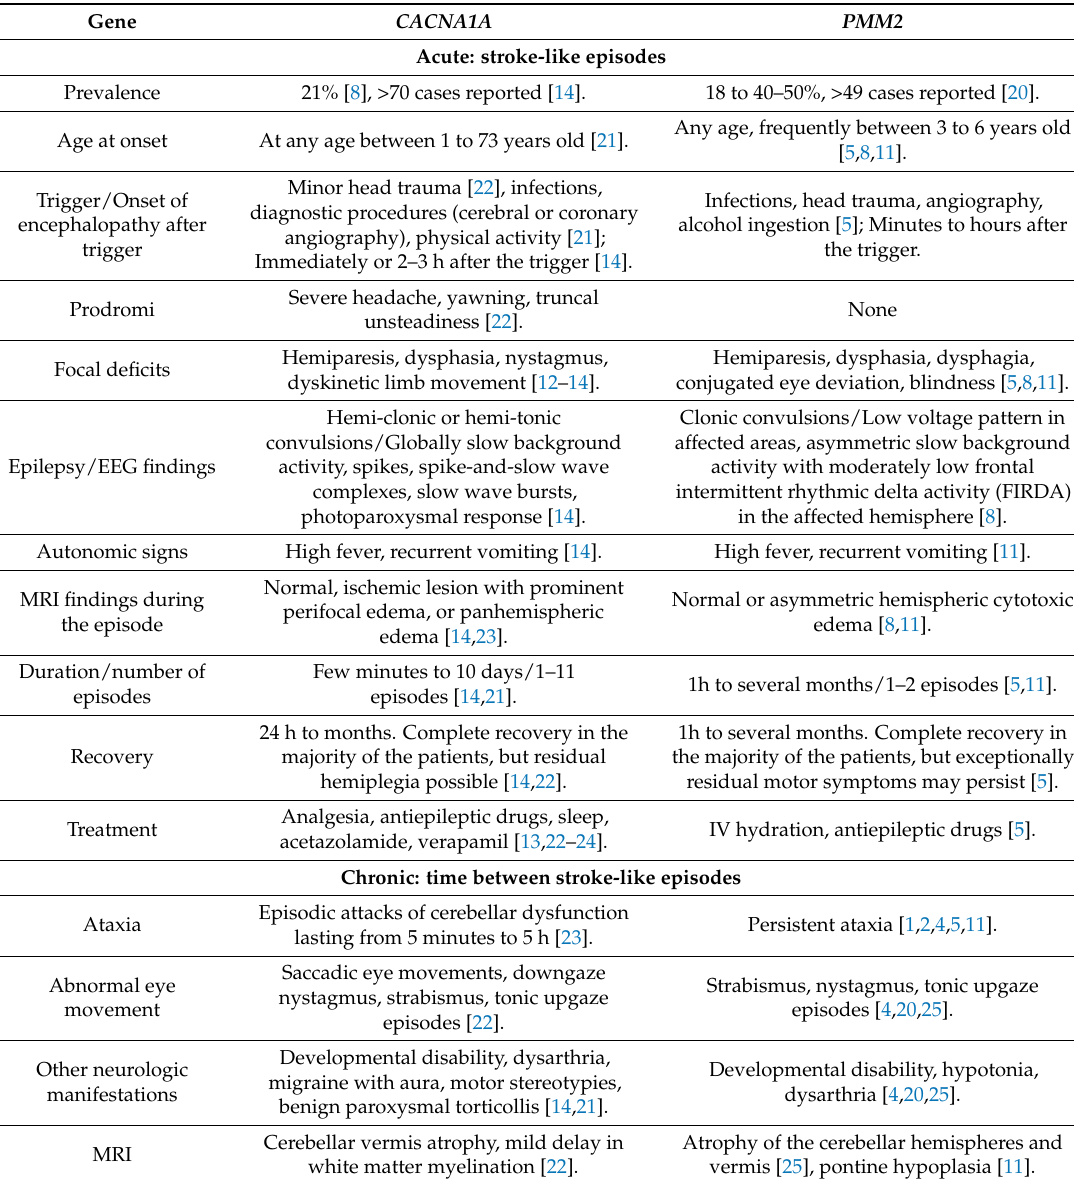
Table 3. Findings in patients carrying mutations in CACNA1A compared to findings in PMM2-CDG patients, including our